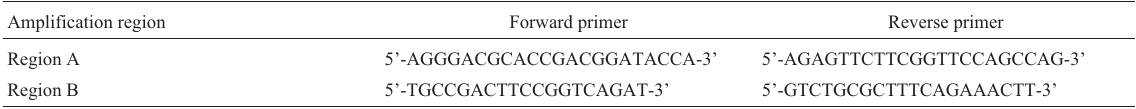
Table 1 - Primer pairs for amplification of the rpoB gene.